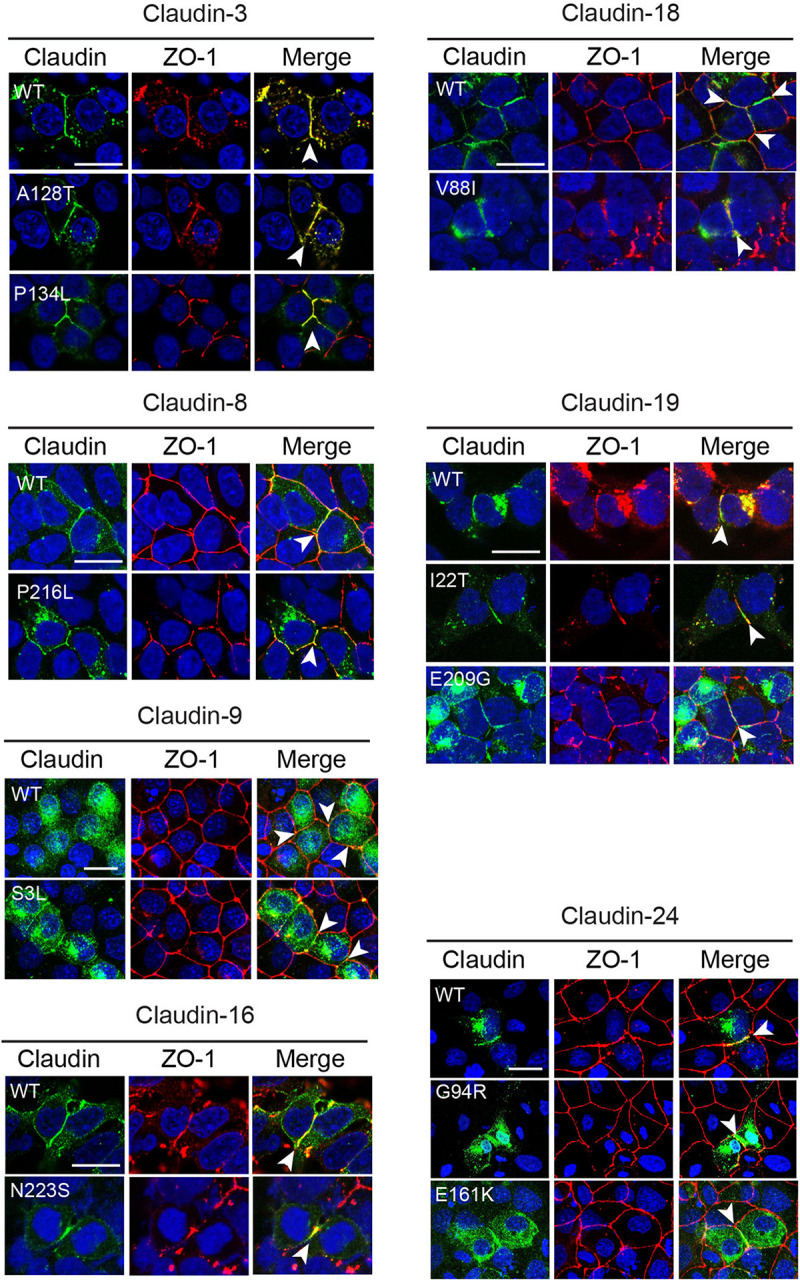
Subcellular localization of CLDN variants. Wild-type (WT) and variant claudins (green) co-localized with the tight junction adaptor protein ZO-1 (red) at the cell membrane (arrowhead) in transiently transfected HEK293 (CLDN3, 4, 8, 16, 18, and 19) or MDCK II cells (Cldn9 and 24). Cldn3, -8, and -16 were detected with anti-claudin antibodies. Cldn9, -18, -19, and -24 were detected with an anti-HA antibody. Blue indicates DAPI stain of the nucleus. The images shown are maximum intensity projections. Scale bar, 20 μm.